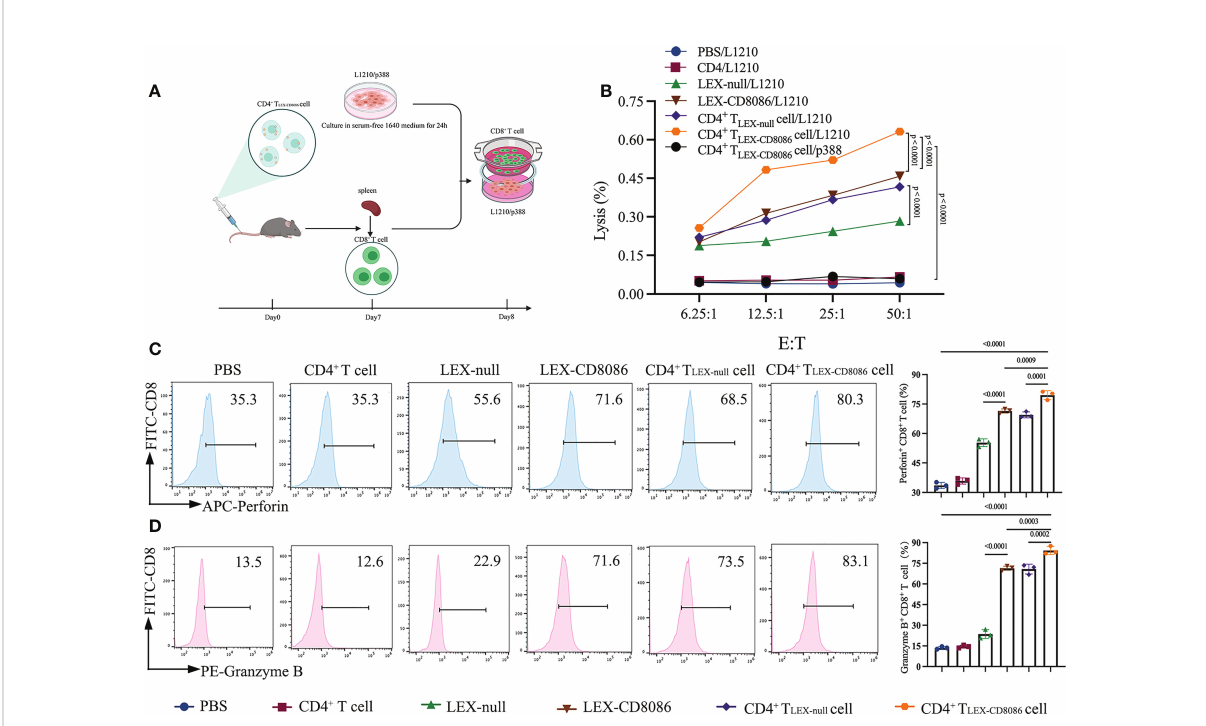
FIGURE 4 Cytotoxicity assay. (A) Schematic protocol of CD8 + T cells isolation from mice immunized with CD4 + T LEX-CD8086 cells. (B) Cytotoxicity assay. The cytotoxic activity of L1210 cells of CD8 + T cells from mice immunized with PBS, CD4 + T cells, LEX-null, LEX-CD8086, CD4 + T LEX-null cells, and CD4 + T LEX-CD8086 cells as assessed by LDH cytotoxicity assay at the indicated effector-to-target (E: T) ratios. The separated viable CD8 + T cells served as effector cells. L1210 or p388 cells served as target cells. (C) Analysis of Perforin expression of CD8 + T cells from mice immunized with the vaccinations as mentioned above (Left) and quantitative analysis of the results of expression of Perforin (Right). (D) Analysis of Granzyme B expression of CD8 + T from mice immunized with the vaccinations as mentioned above formulations ( Left ) and quantitative analysis of the results of expression of Granzyme B ( Right ) . All the results shown above represent at least three independent experiments. Data are mean ± SD of three independent biological replicates. P values are from